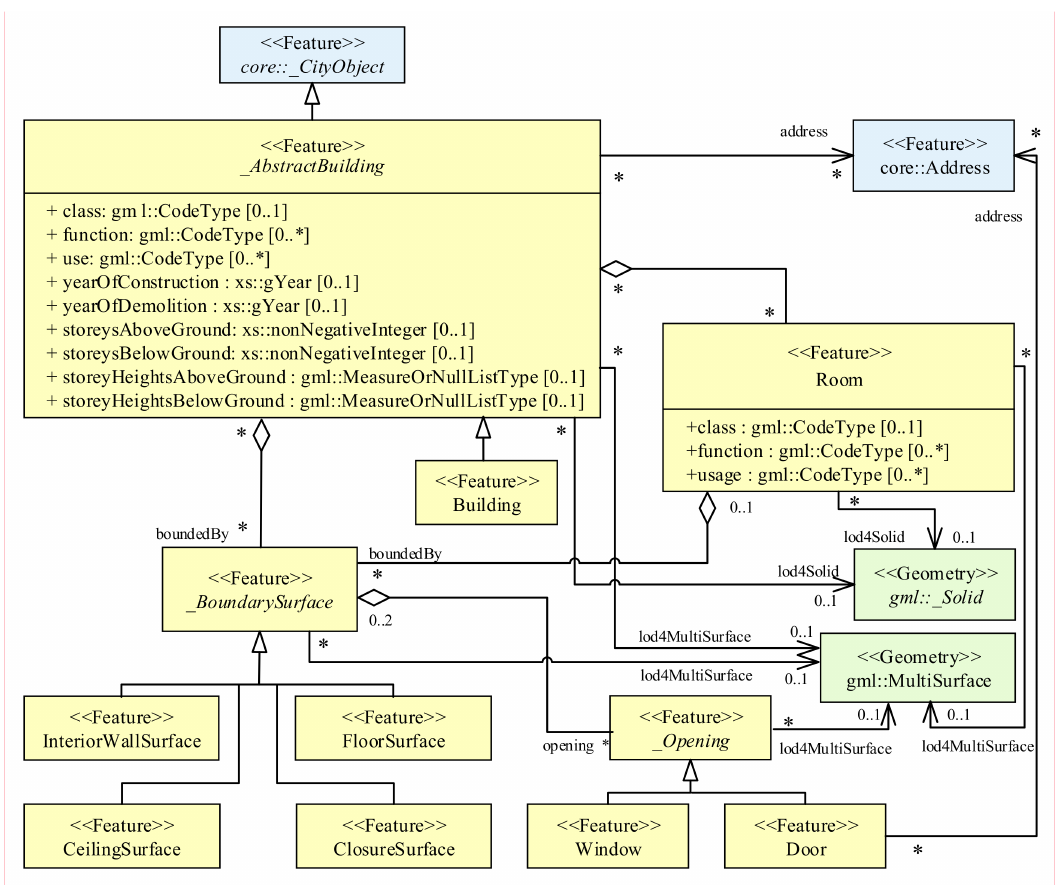
Figure 6. UML diagram of Simplified 3D Indoor Space Model (3DSISM) based on